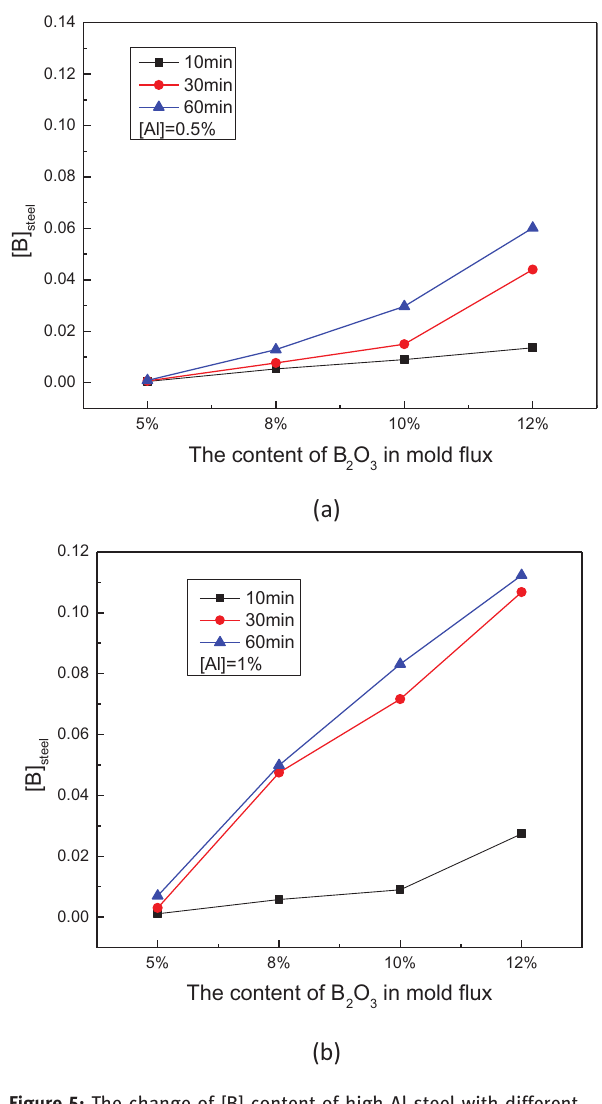
Figure 5: The change of [B] content of high Al steel with different reaction